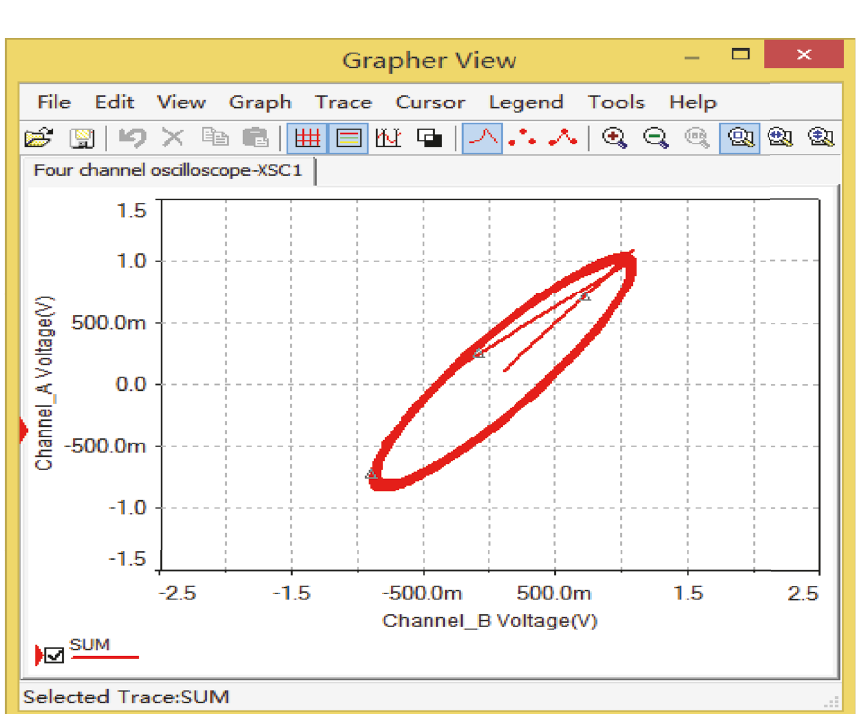
Figure 26: Phase portrait of